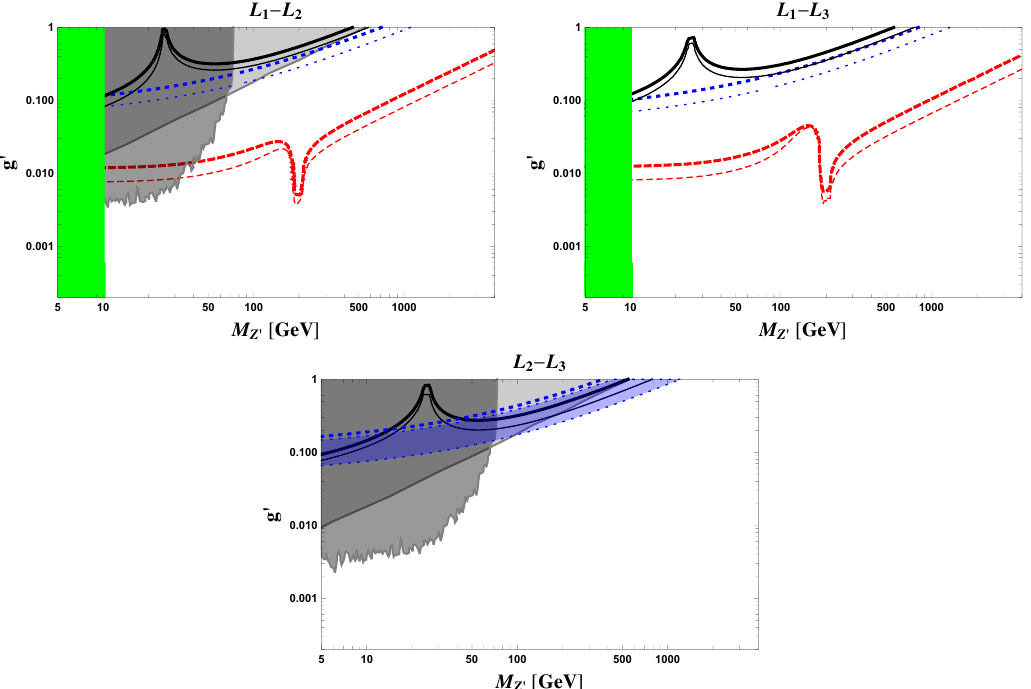
Figure 1 . Bounds on g 0 and M Z 0 for the L i (cid:0) L j models. The thin (thick) dashed-red, dotted- blue, and solid-black curves correspond to 1 (cid:27) (2 (cid:27) ) bounds from LEP search [18], HFAG lepton universality test [16], and SLD/LEP Z -decay lepton universality test [15], respectively. The green region is excluded by BaBar bounds [19]. The lighter- and darker-grey regions are excluded by neutrino-trident bound [26, 27] and the LHC bound for Z ! 4 (cid:22) [28] respectively. In the L 2 (cid:0) L 3 case, the blue-shaded region is the 1 (cid:27) -allowed region by HFAG lepton universality test. The 2 (cid:27) - allowed region is below the thick dotted-blue curve. Note the absence of the BaBar and LEP bounds in this case where Z 0 does not couple to